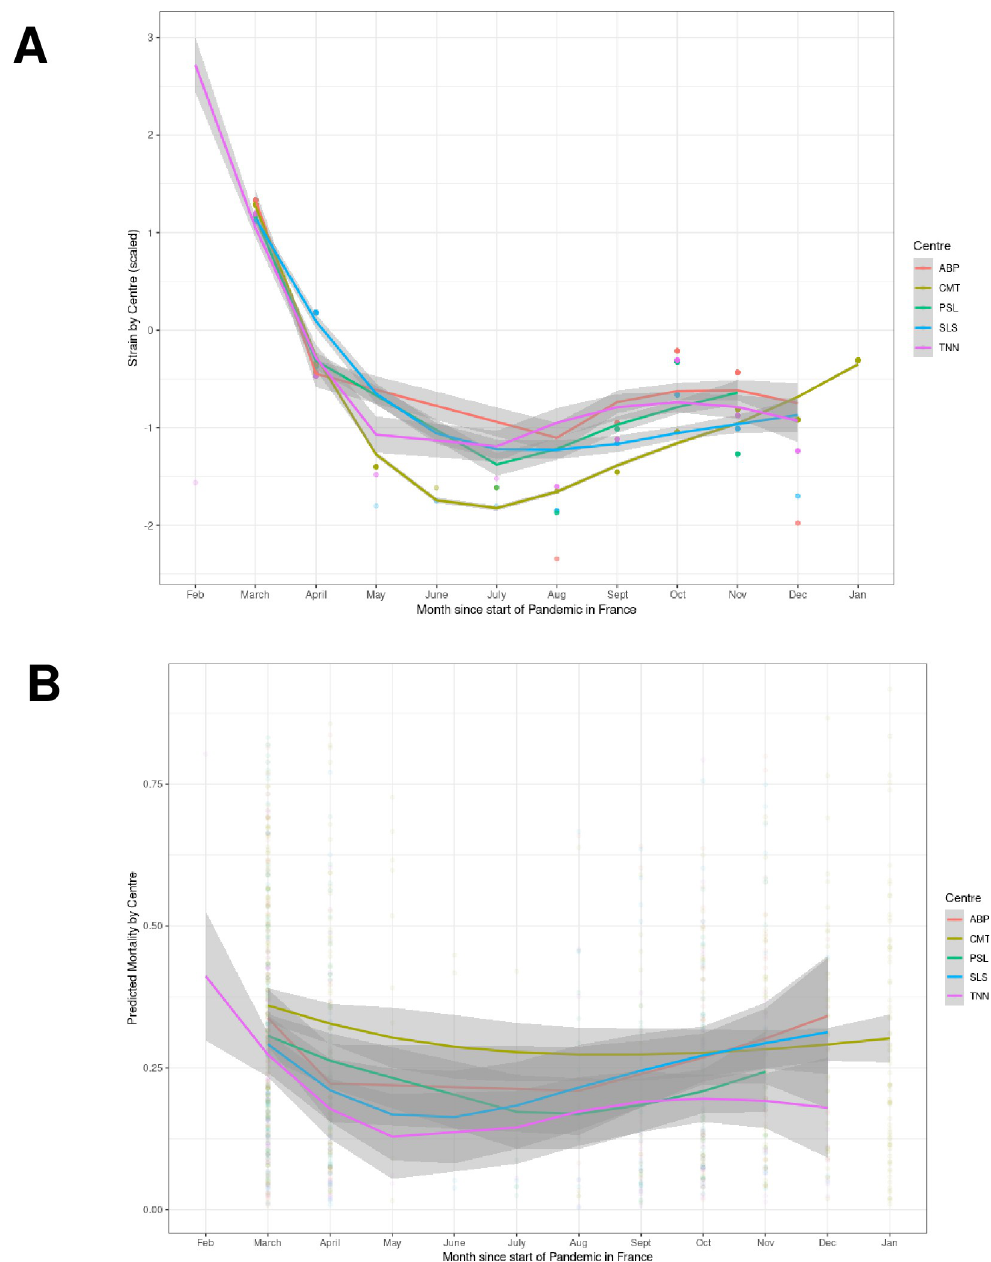
Fig 1. Evolution of intensive care unit (ICU) strain (Panel A) and predicted mortality (Panel B) over the entire study period. ICU strain within center was calculated as follows: (number of COVID-19 admission in each center–mean number of COVID-19 admission in each center during the whole period) / standard deviation of admission in each center. Bold line and gray area represent respectively mean by center and 95% confidence interval. Table 3 shows the factors associated with 28-day mortality by univariate analysis. After adjustment for confounders, including random effect on center on the intercept, five variables were independently associated with 28-day mortality (area under the curve of the model 0.76, 95% CI 0.73–0.79). Overweight and obesity (respectively odds ratio [OR] 0.69; 95% confidence interval [CI] 0.48–0.98, and 0.59; 95% CI 0.41–0.85) were associated with lower mortality